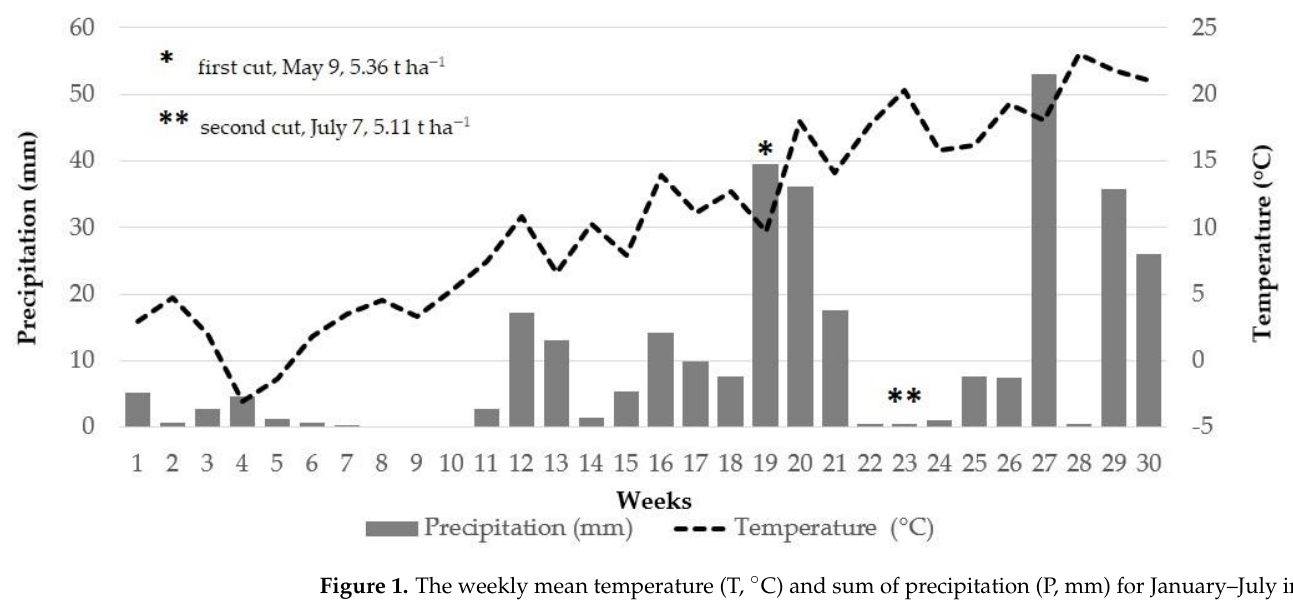
Figure 1. The weekly mean temperature (T, °C) and sum of precipitation (P, mm) for January – July in 2014 together with lucerne harvest date and average dry matter yield (DMY, t ha −1 ). Dry forage leaf and stem samples were homogenized to a particle size of 1 mm and analyzed for starch and WSC in the accredited laboratory of Ekolab Žamberk Ltd (Žam- berk, Czech Republic). Starch was measured by polarimetric (Ewers) method, where